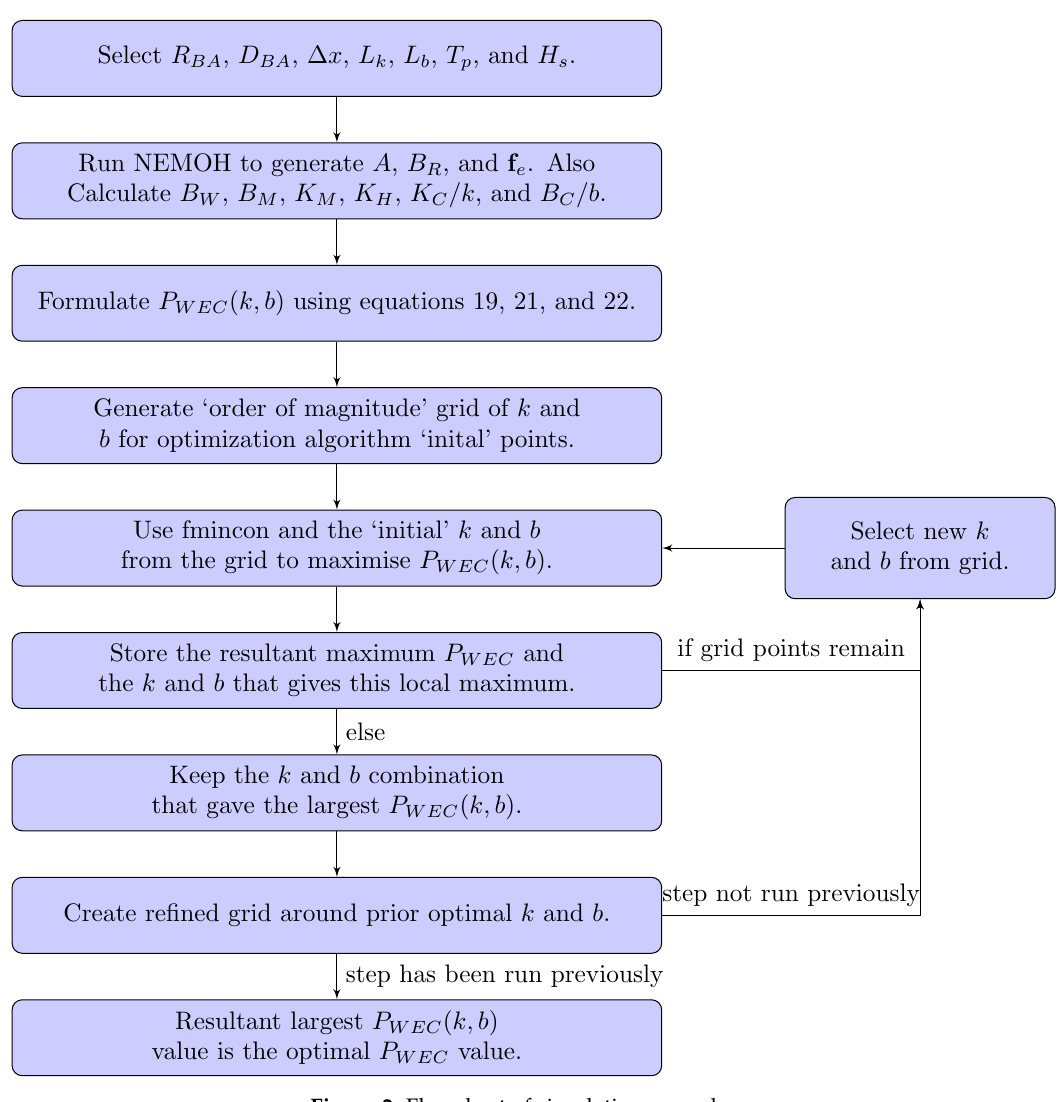
Figure 2. Flowchart of simulation